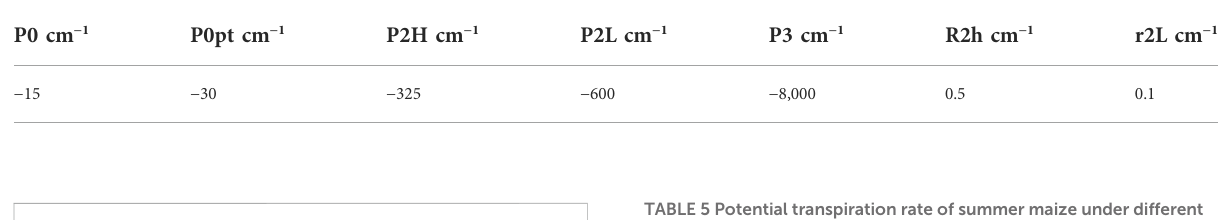
TABLE 5 Potential transpiration rate of summer maize under different drought conditions.